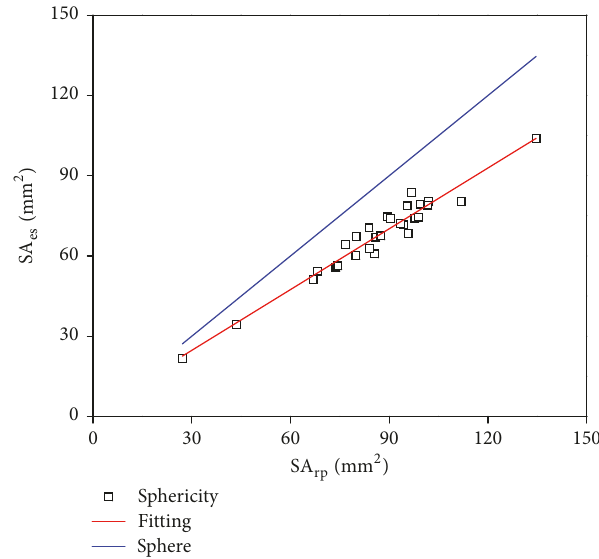
Figure 9: Sphericity of twenty-eight iron ore